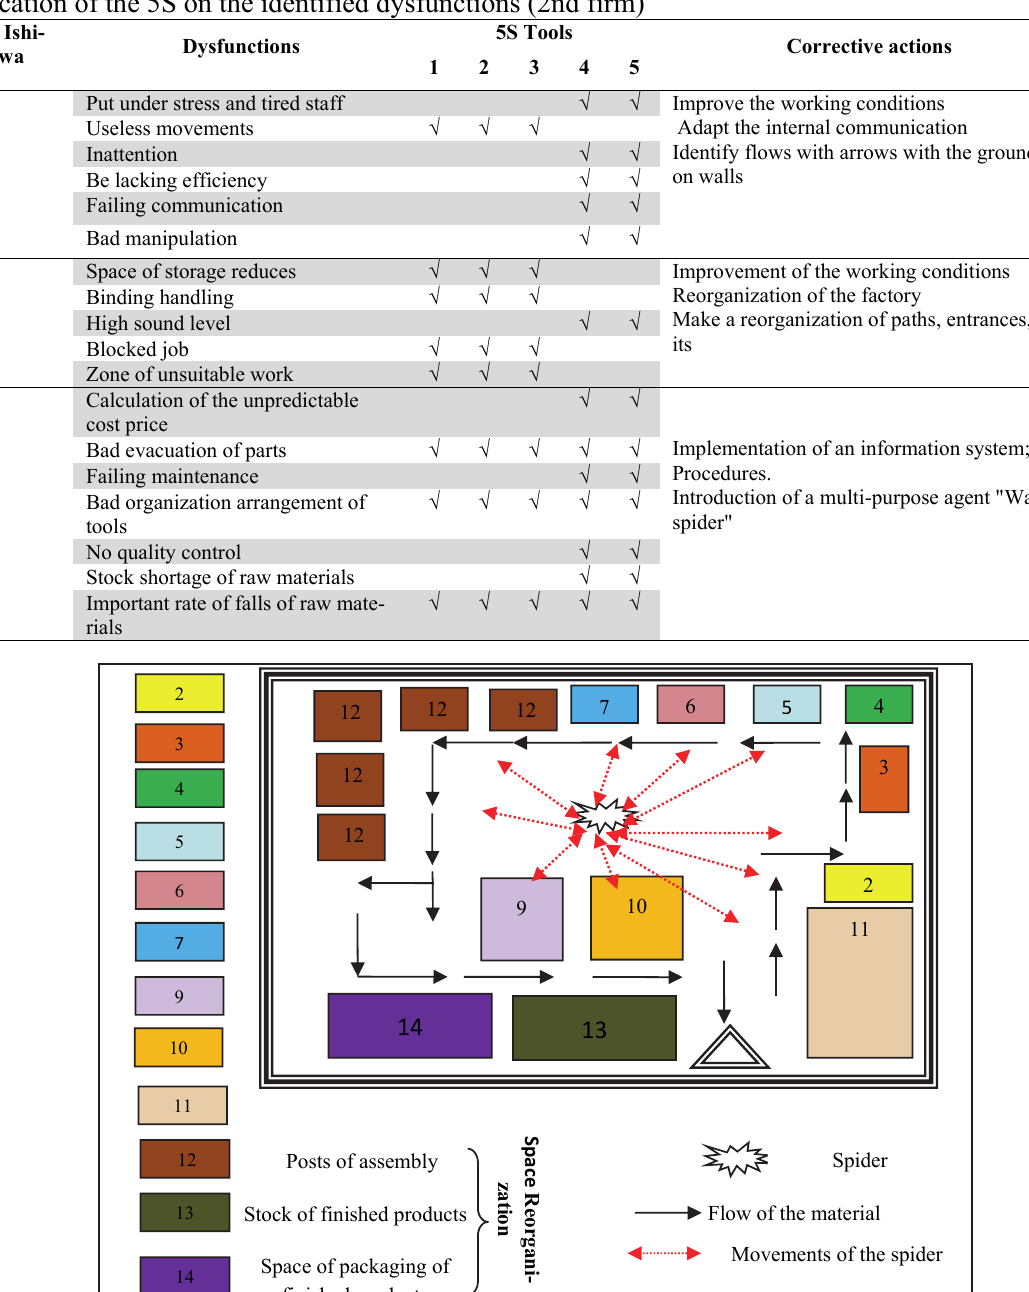
Application of the 5S on the identified dysfunctions (2nd firm)